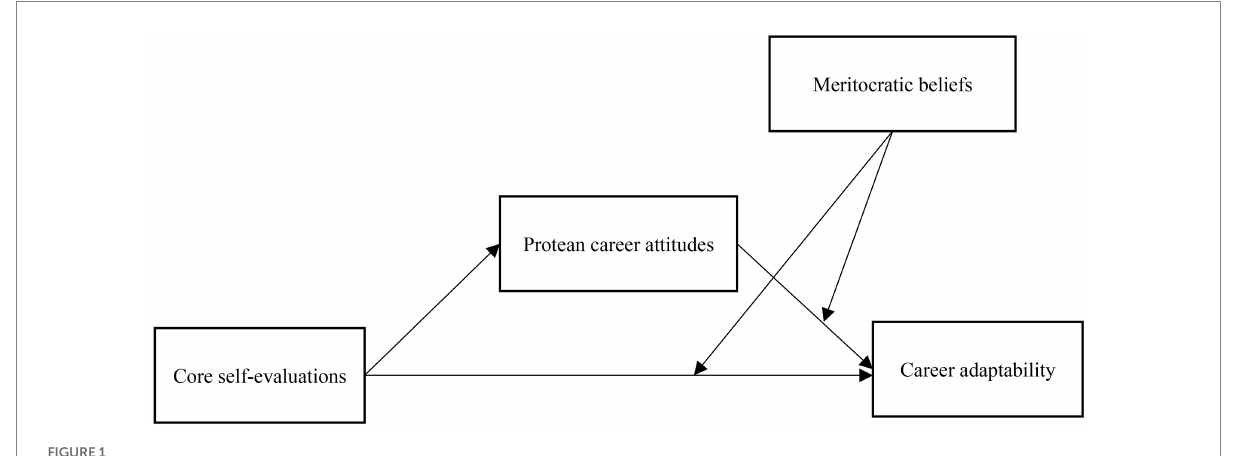
FIGURE 1 The proposed moderated mediation